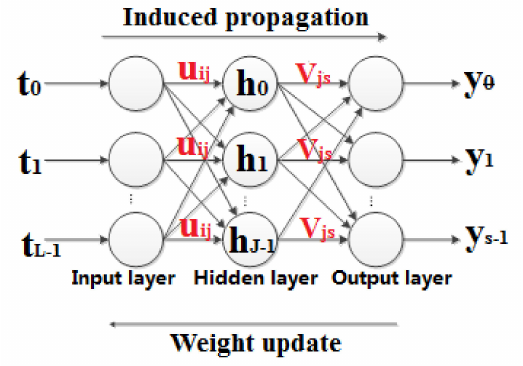
Figure 4. Structure of the back-propagation neural network